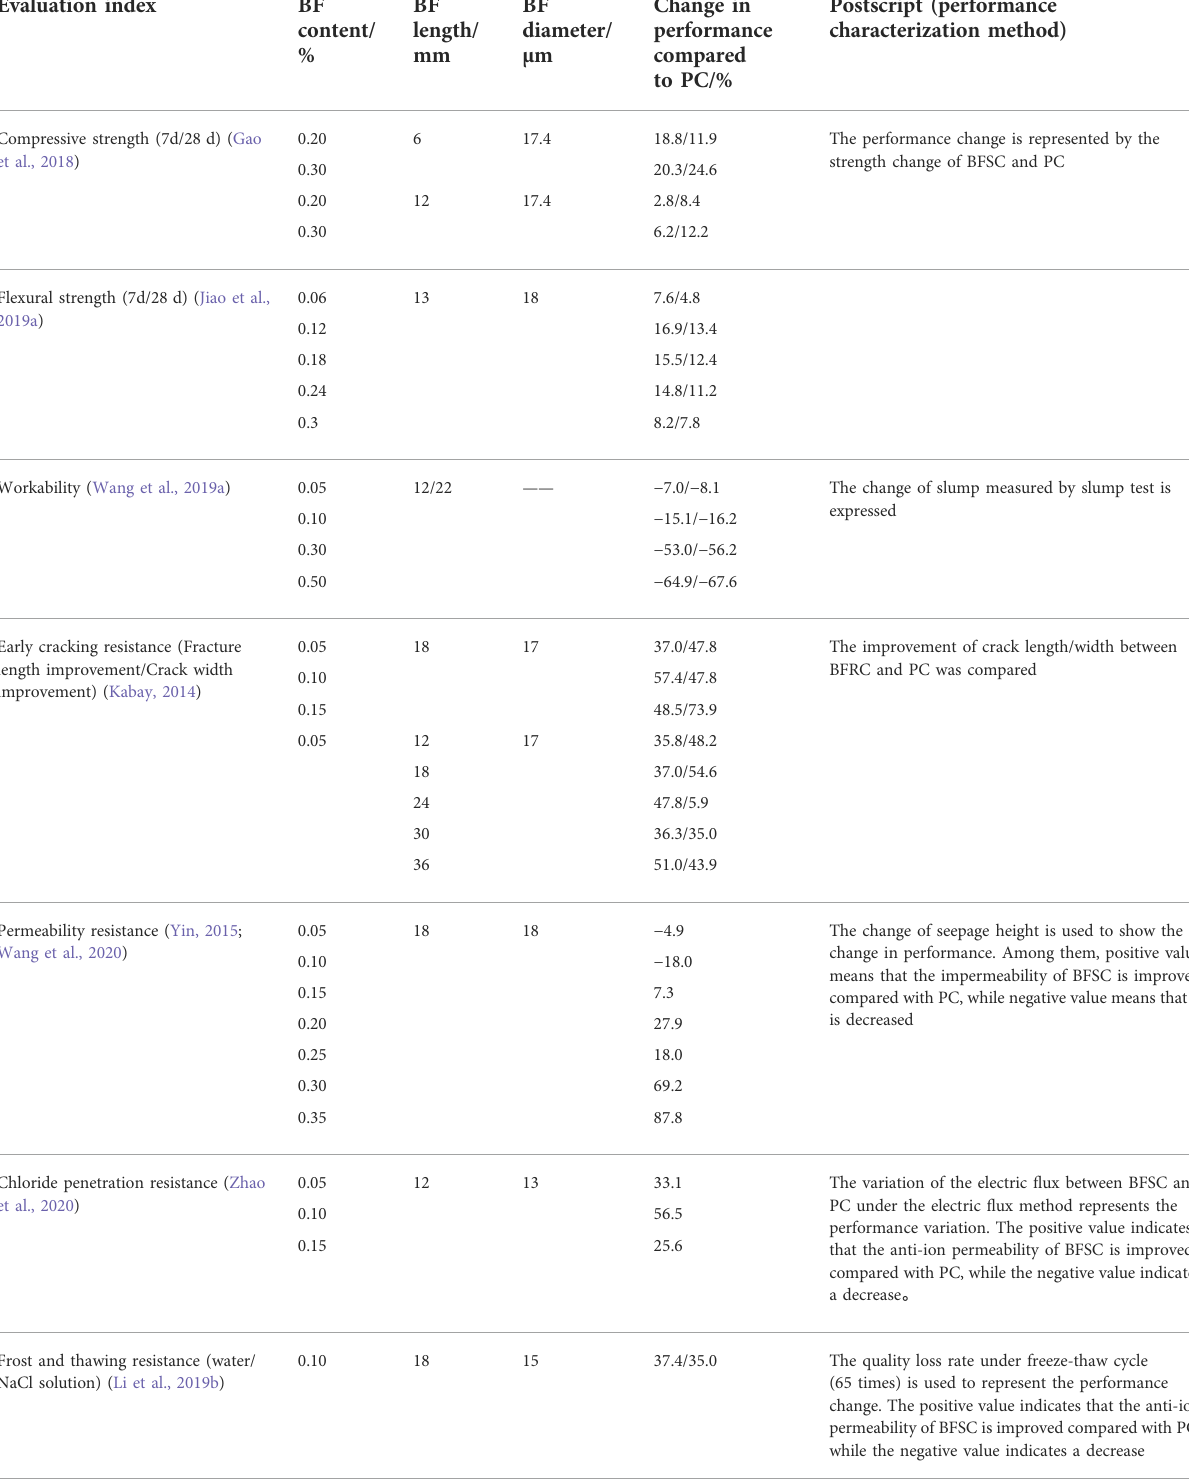
TABLE 3 Summary of performance comparison between SC and